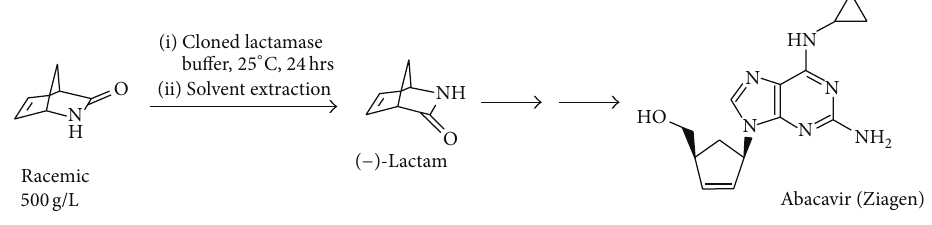
Scheme 1: The lactamase catalytic